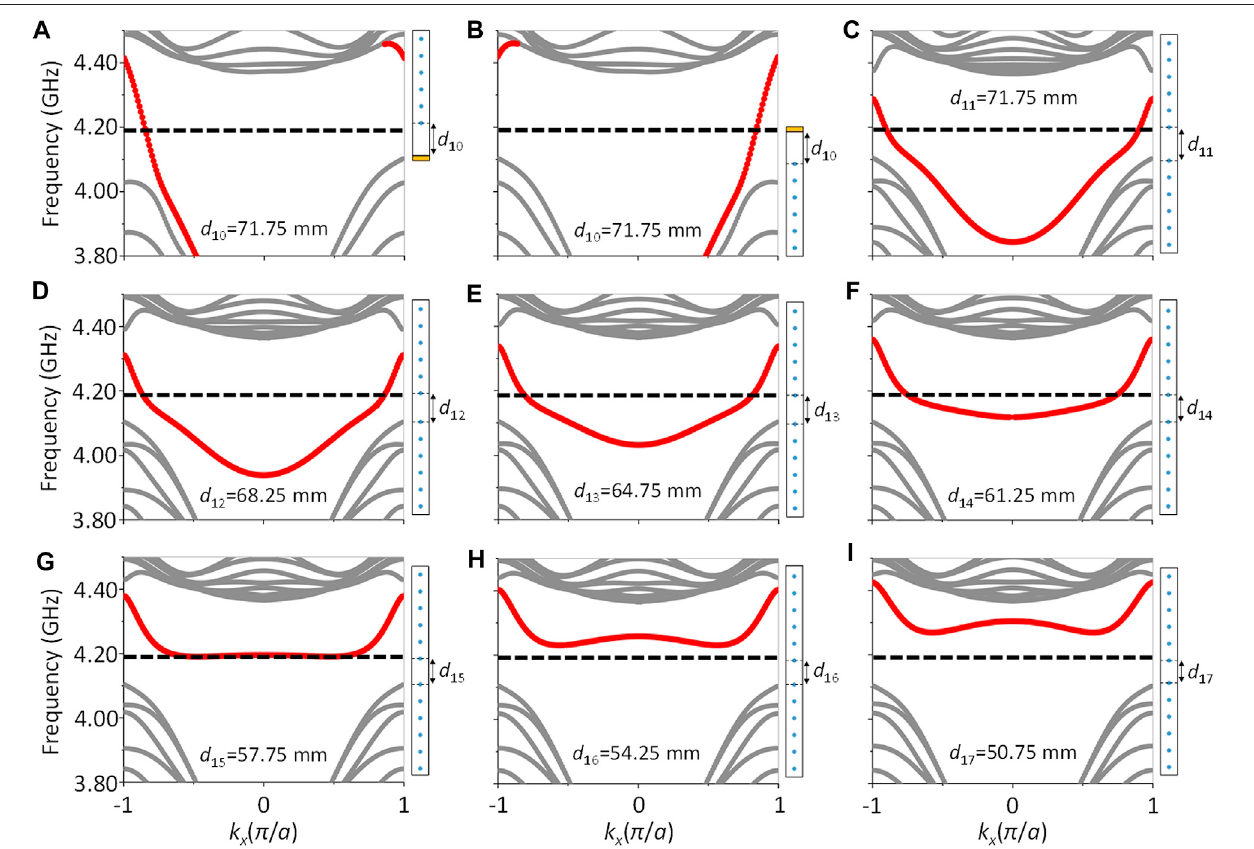
FIGURE 2 | Projected band structure. (A) Upper halfGPC with a waveguide width d 10 (cid:1) 71.75 mm. (B) Lower half GPC with d 10 (cid:1) 71.75 mm. The yellow layers in (a) and (b) aretheperfectelectricconductors. (c – i) GPCwaveguidecomposedoftwoGPCswithdifferentwaveguidewidths: (C) d 11 (cid:1) 71.75 mm, (D) d 12 (cid:1) 68.25 mm, (E) d 13 (cid:1) 64.75 mm, (F) d 14 (cid:1) 61.25 mm, (G) d 15 (cid:1) 57.75 mm, (H) d 16 (cid:1) 54.25 mm, and (I) d 17 (cid:1) 50.75 mm. The frequency marked by the black dotted line is 4.1902